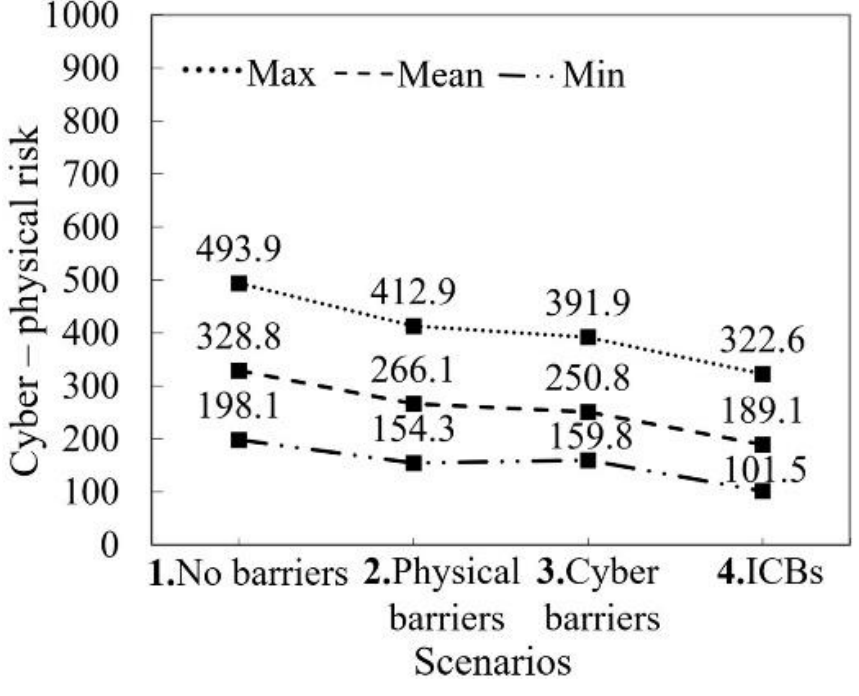
Figure 6. Cyber-physical risk when no importance index is considered (i.e., W i = 1). Finally, a sensitivity analysis for the proposed threat source characteristic of Terrorism experience, in the Monte Carlo simulations was undertaken to demonstrate the relevance of the decision score of this characteristic. By keeping constant all the inputs (i.e., X i , W i ) from Scenario 1, as in Table 4, three categories of threat source related to intensity score of Terrorism experience are considered. The specific categories capture real examples from a